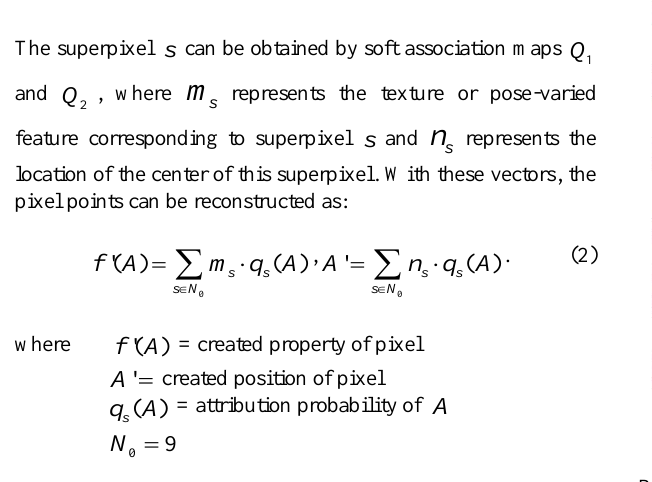
Figure 3 . The structure of FCN network for predicted soft association map.